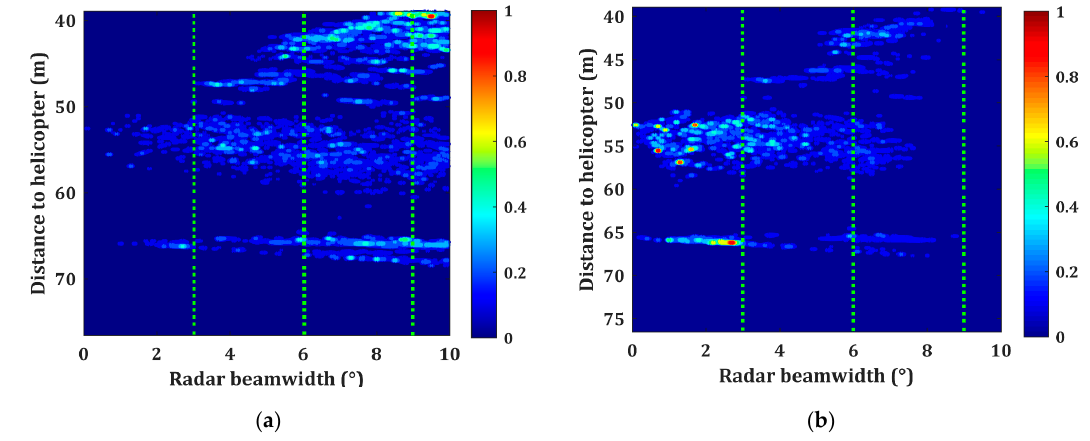
Figure 8. ( a ) The relative point density defined by the 6700th Tomoradar measurement. ( b ) The contribution of lidar points within each block for the simulated-waveform. All results are normalized by the corresponding maximums, and the locations of three green lines from left to right are 3°, 6°, and 9°.